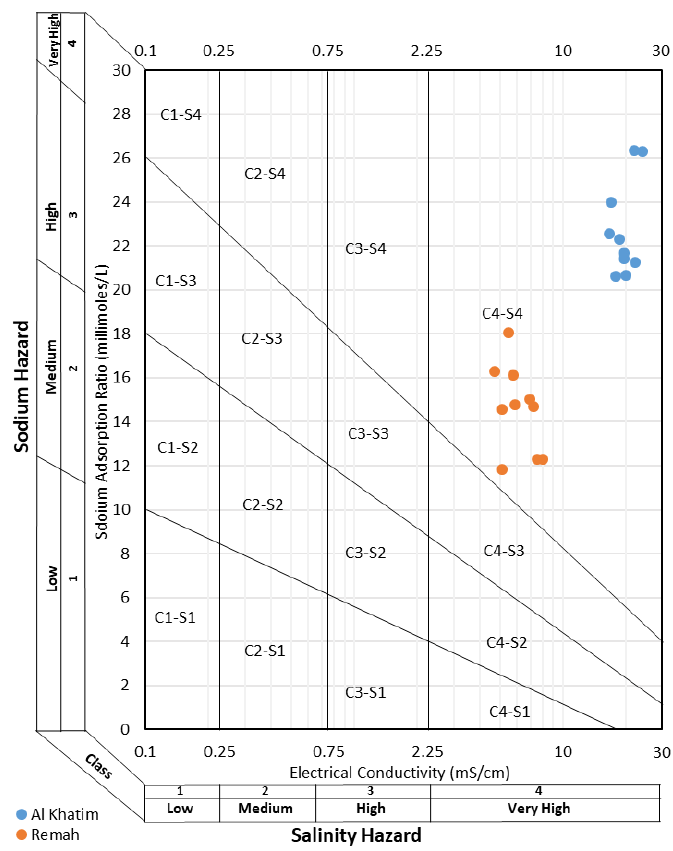
Figure 16. Extended Wilcox plot showing irrigation water classification.